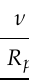
Figure 19. Comparison of probability density function of R based on the wave slope distribu- Table 3. List of most probable armor block strength for varying bandwidth of wave spectrum. tion presented in this study with the one based on the Gaussian distribution [ 2 .3 0.6 ν = ].